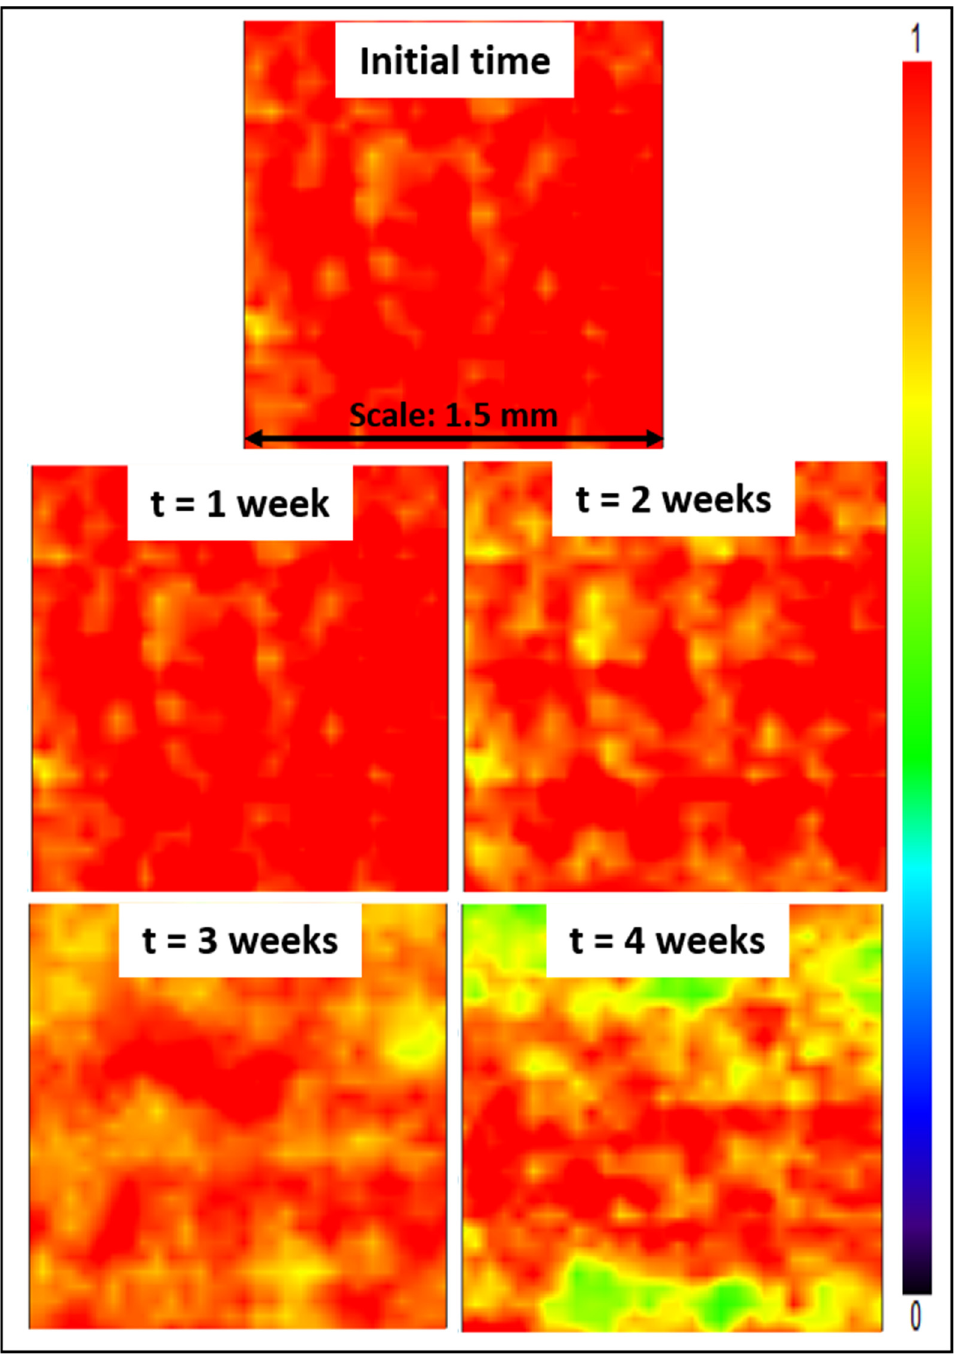
Figure 13. Mapping FT-IR images at 1727 cm − 1 before and after immersing the membranes in DI water for 4 weeks.